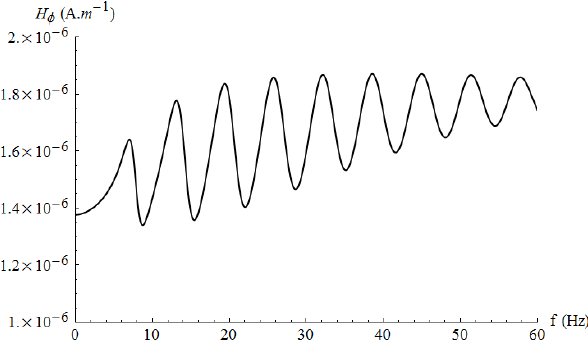
Figure 14: Magnetic field versus frequency at a distance of 1000 km from the source.